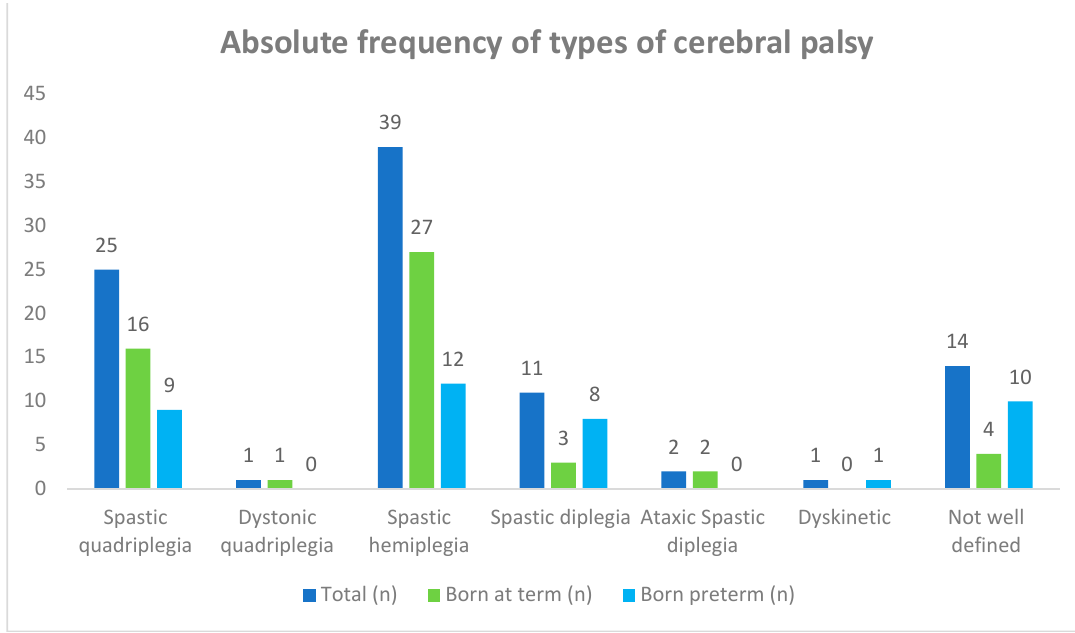
Children 2021 , 8 , x FOR PEER REVIEW Figure 1. Absolute frequency of types of cerebral palsy (CP) in 93 affected children born at term and preterm.